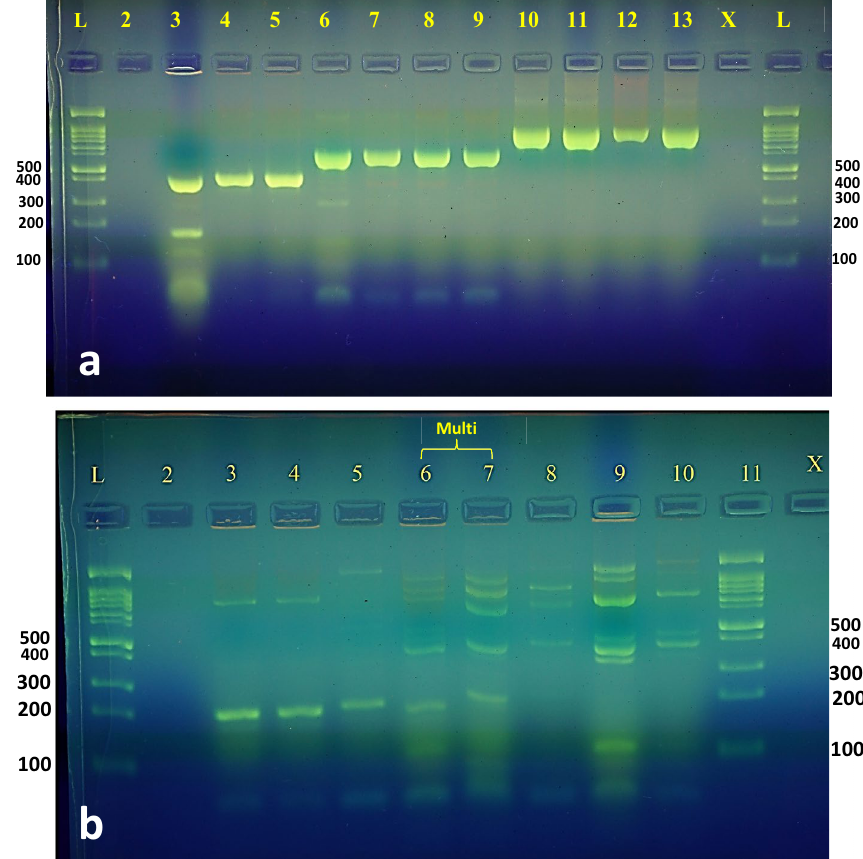
Figure 1. PCR detection of carbapenemase resistance genes KPC, NDM, OXA (a) and VIM, IMP (b) in CPGB. ( a ) Lanes (3–5), (6–9) and (10–13) imply the OXA-48, NDM, and KPC-positive genes, respectively. ( b ) Lanes (3–5) and (8–10) indicate the IMP and VIM carbapenemase positive genes, respectively, lanes 6 and 7 signify “Multi” coexistence of the VIM and IMP genes. The molecular size of bla NDM , bla OXA-48 , bla KPC, bla VIM and bla IMP carbapenemase genes tested are 621, 438, and 798, 390 and 232 bp, respectively. Lanes (1,11) in (a) and (1,14) in (b) are 1-kb DNA ladders. Negative control of both figures was in lane